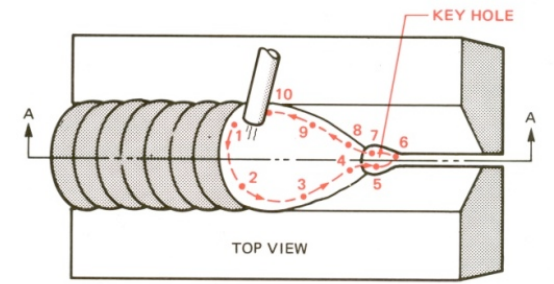
Fig. 25. Overwelding due to increased root opening of the groove [8]